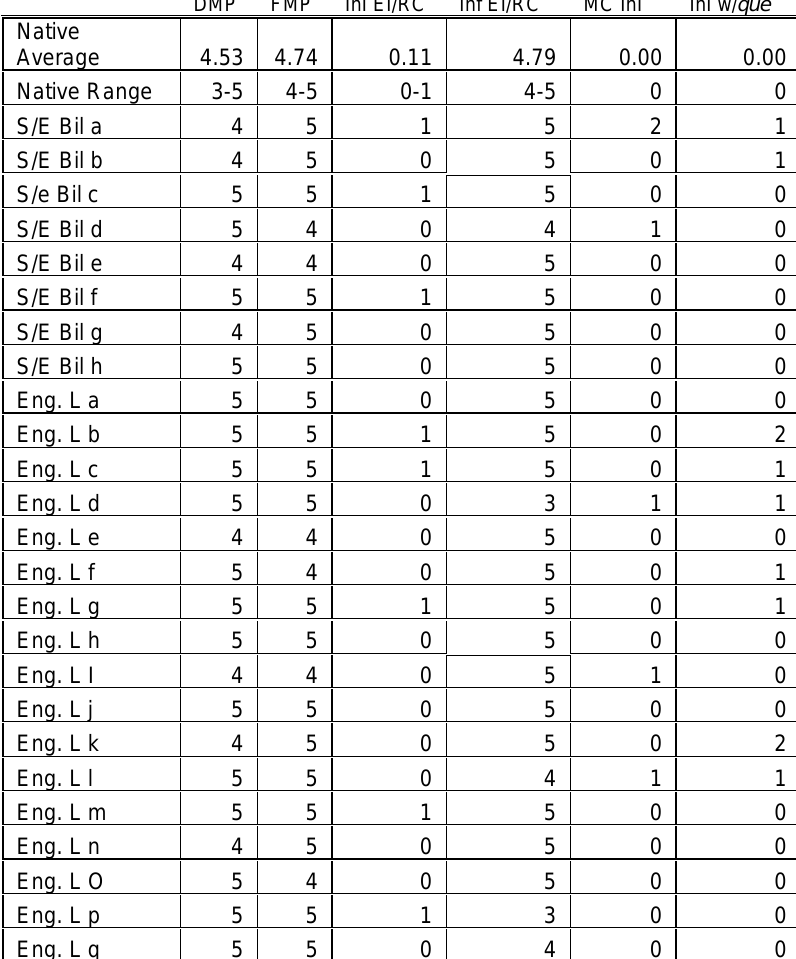
Table I: Individual Results from Task